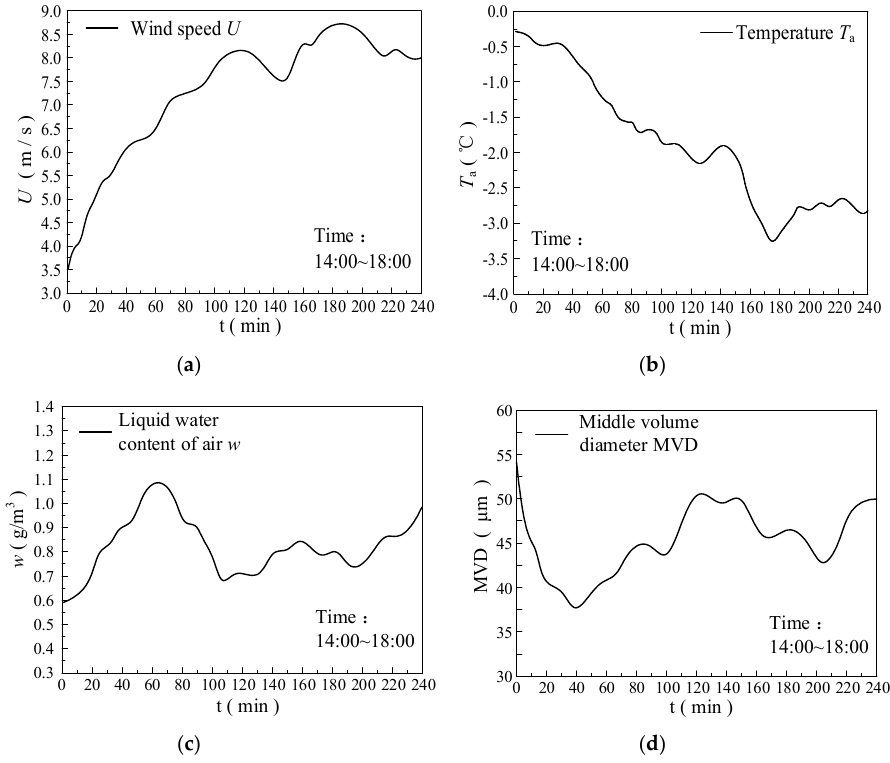
Figure 9. The climate parameters at Xuefeng Mountain, China during an icing period: ( a ) wind speed; ( b ) temperature; ( c ) liquid water content of air; and ( d ) median volume diameter (MVD) of water droplets.